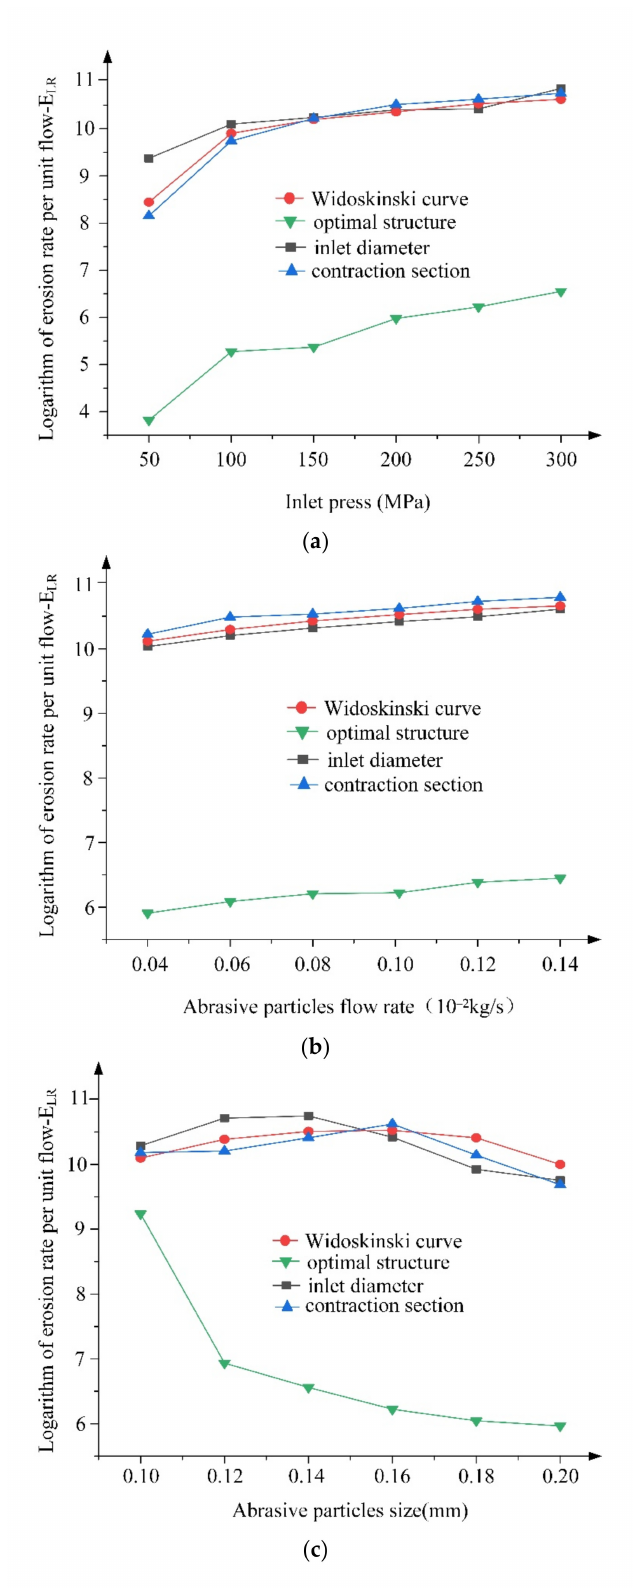
Figure 14. Logarithmic diagram of peak erosion rate per unit flow of various nozzles under different system parameters: ( a ) inlet pressure effects on the logarithm unit flow erosion rate; ( b ) abrasive flow rate effects on the logarithm unit flow erosion rate; ( c ) particle size effects on the logarithm unit flow erosion